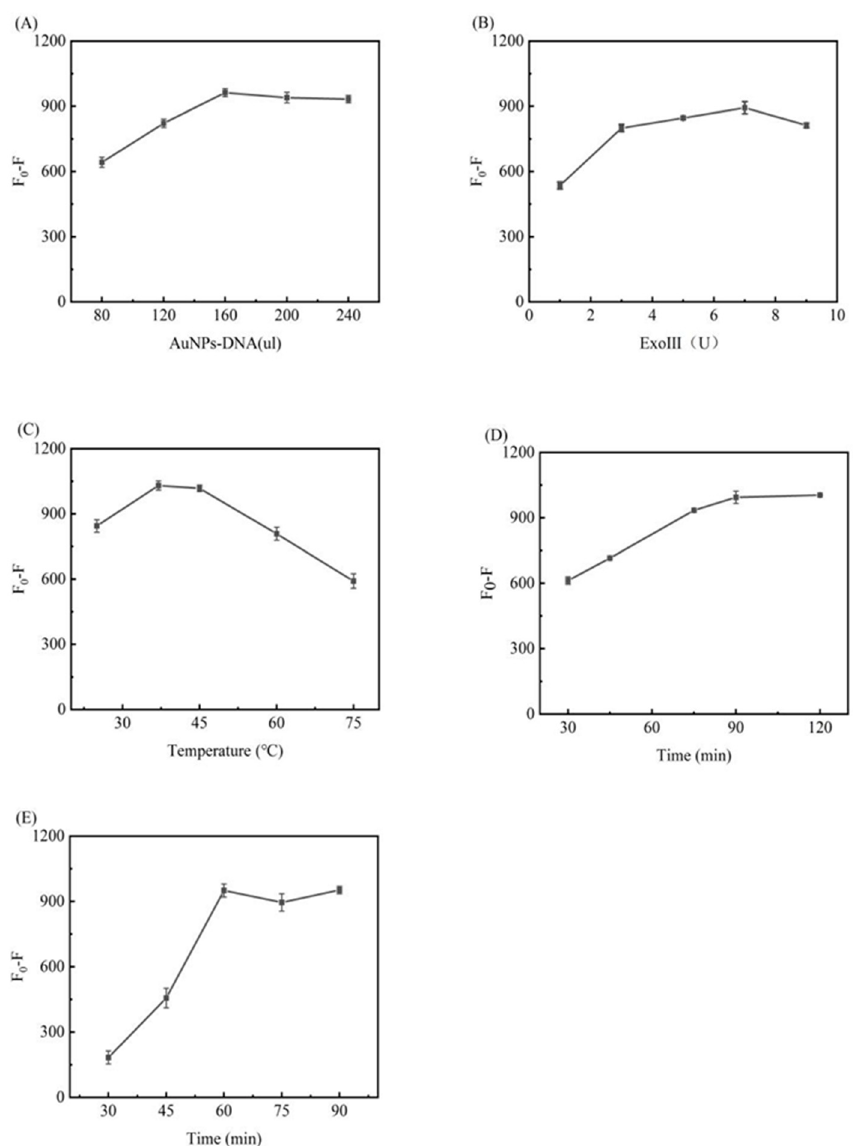
Figure 4. Optimization of the experimental conditions: ( A ) volume of AuNPs–DNA added; ( B ) con- centration of Exo III added; ( C ) change in the reaction temperature; ( D , E ) optimization of the reaction time, corresponding to fluorescence quenching, where ( D ) shows the extinction stage and ( E ) shows the fluorescence recovery stage.